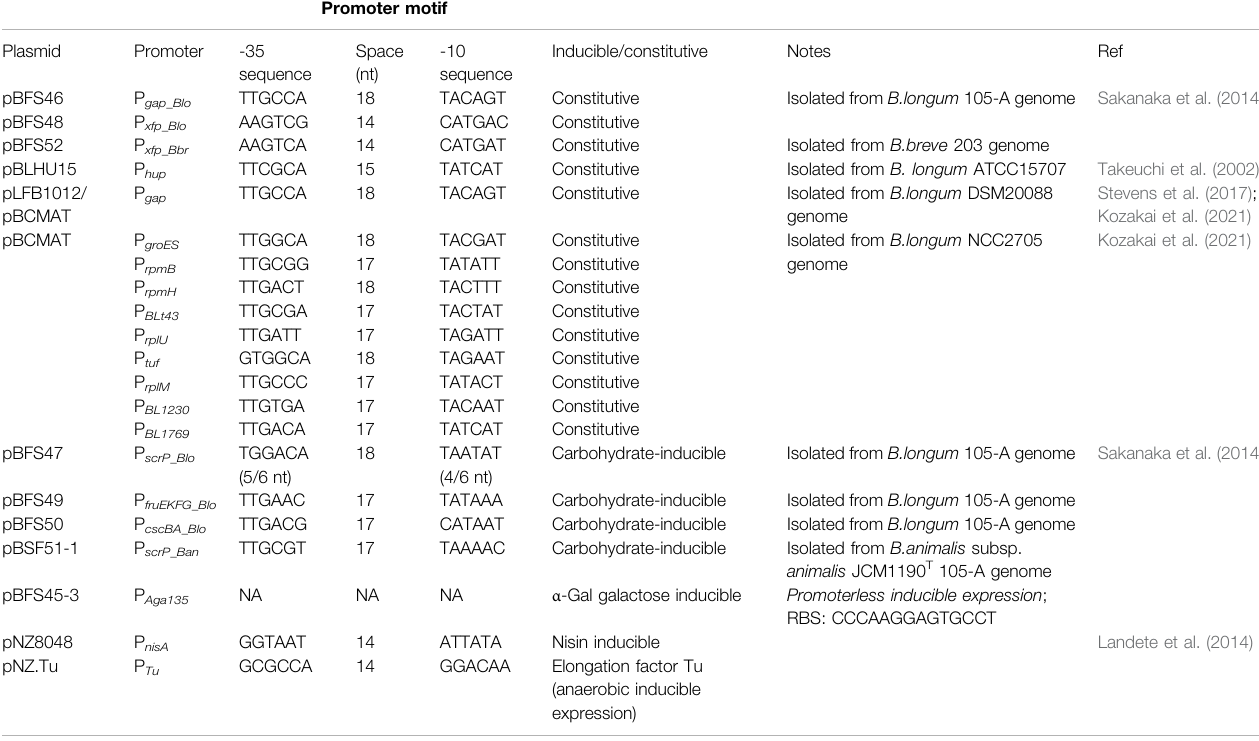
TABLE 3 | The list of promoter sequences used in Bi fi dobacterial engineering.